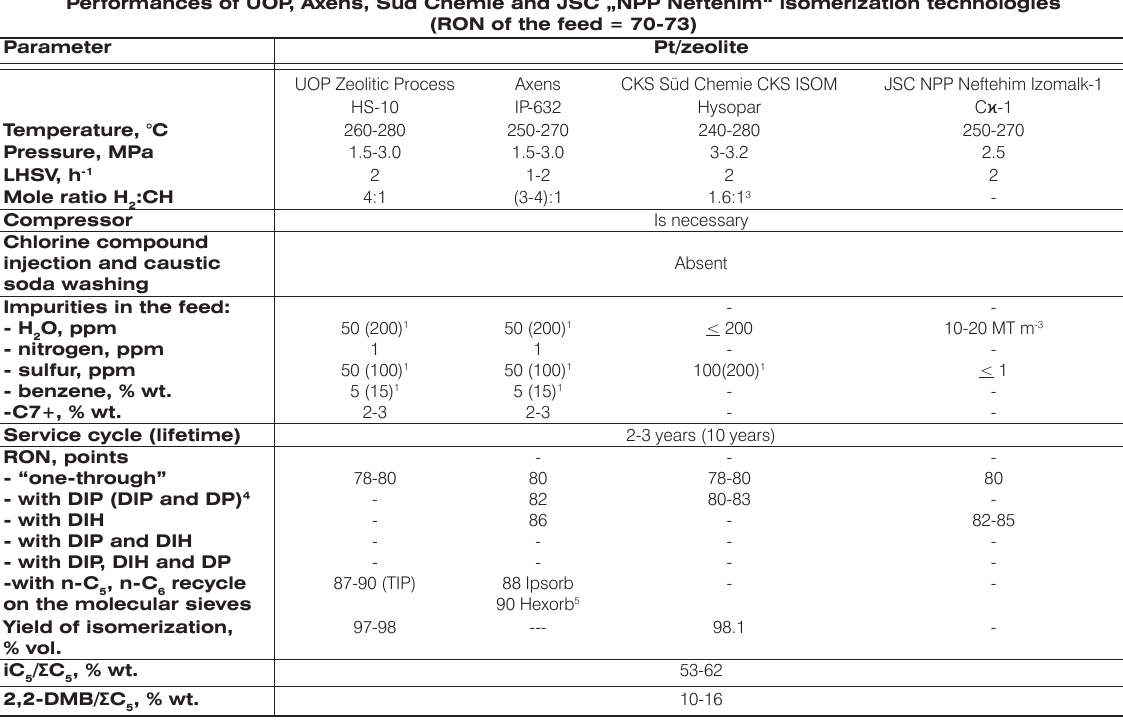
O catalysts, yields, obtained Research Octane Numbers [21]. 2 3 (RON of the feed = 70-73)